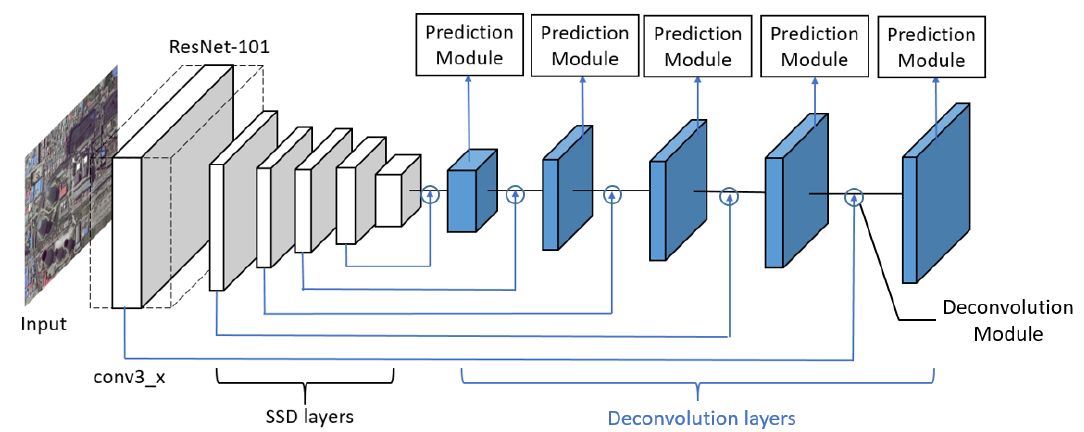
Figure 6. The framework of DSSD. Conv, convolutional